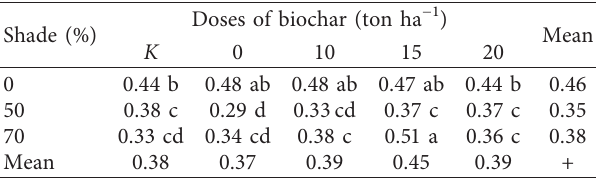
Table 13: Effects of biochar and shade application on the quercetin content